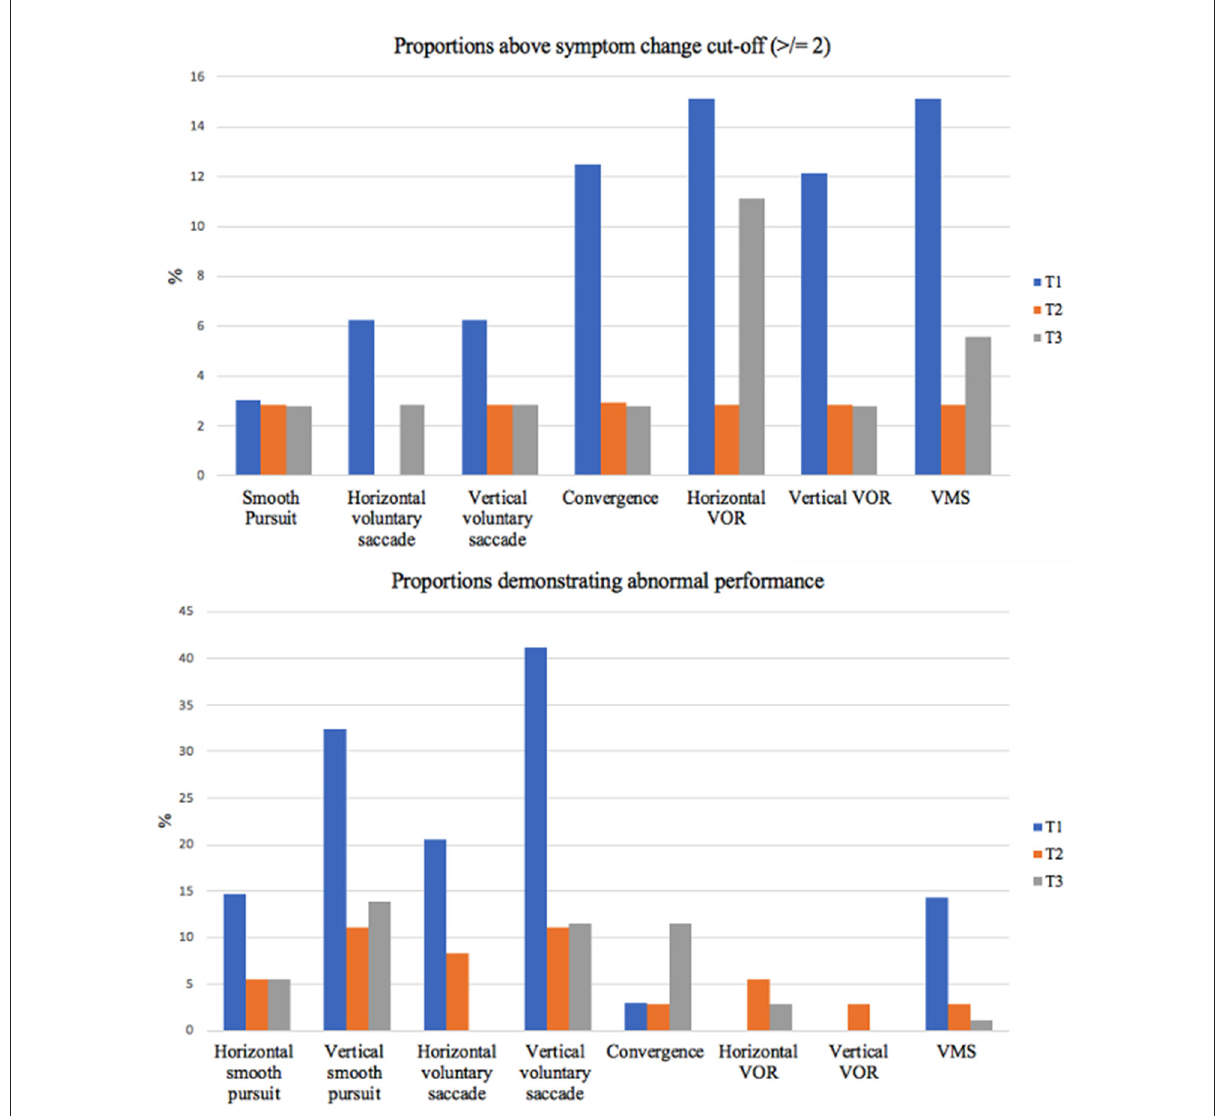
FIGURE1 Abnormal performance and symptom provocation proportions over time. This figure outlines the proportions of our sample demonstrating symptom provocation of 2 or more (top) and abnormal performance (bottom) on each VOMS component. VOR, vestibulo-ocular reflex; VMS, visual motion sensitivity; T,